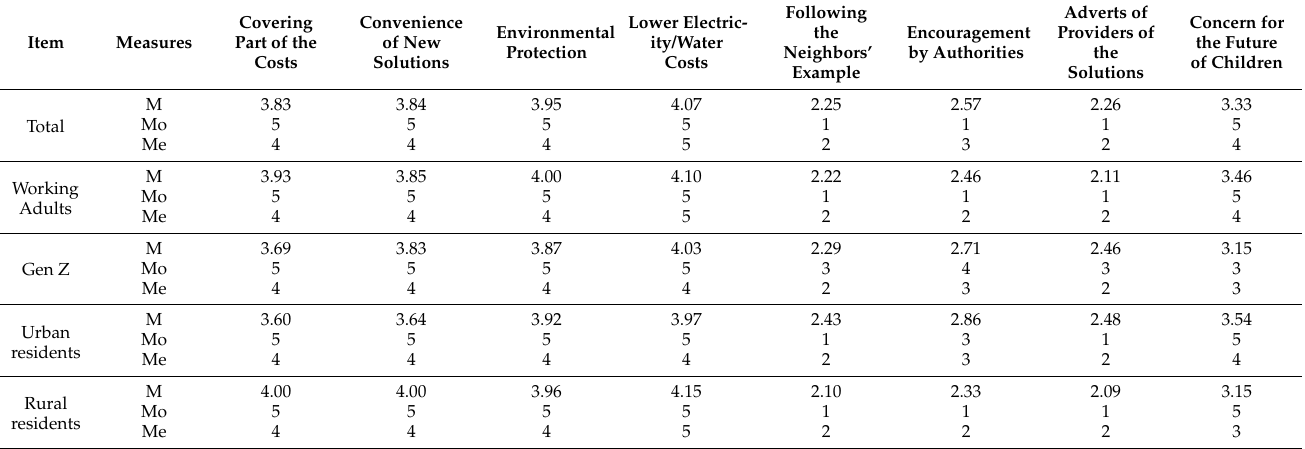
Table 4. Reasons motivating respondents to use the pro-environmental programs by age and place of residence (5-point Likert scale, where 1-not important, 5-very